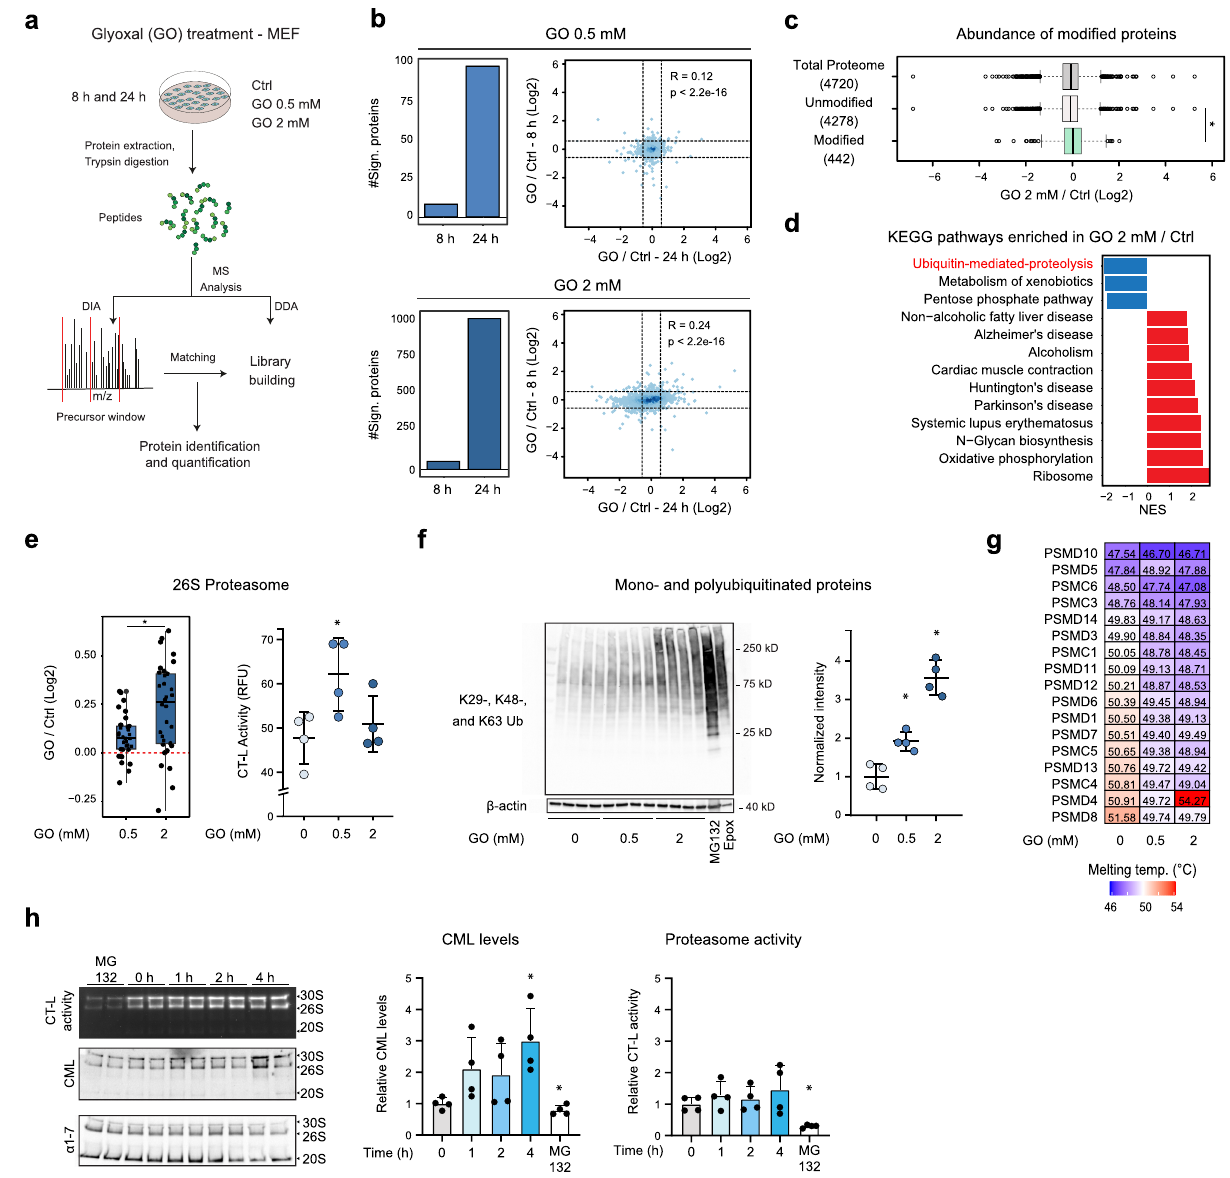
Fig. 3 Alteration of proteostasis induced by glyoxal in MEF. a Work fl ow for the analysis of proteome changes induced in MEF by GO. b Left, number of signi fi cant proteins (absolute log2 fold change>0.58 and q < 0.05) after 8 and 24 h GO treatment. Right, scatterplots comparing the log2 fold changes induced by GO at 8 or 24 h. Dashed lines represent the log2 fold change cut-offs used (±0.58). n = 5 (8 h), n = 4 (24 h). Pearson ’ s product-moment correlation, two-sided. c Distribution of protein fold changes for 2 mM GO (24 h) vs. control (Ctrl). Average values of n = 4 were compared, * p < 0.001, Wilcoxon rank sum test with continuity correction, two-sided. d Gene Set Enrichment Analysis (GSEA) for KEGG pathways based on protein fold changes induced by 2 mM GO (24 h). Normalized enrichment score (NES) indicates pathways enriched among proteins that increase (red) or decrease (blue) upon GO treatment (FDR < 0.05). All quanti fi ed proteins were ranked according to their log2 fold change and used as input for GSEA. e Left, boxplot of fold changes in expression of members of the 26S proteasome after GO treatment (24 h). * p < 0.01, Wilcoxon Rank Sum test with continuity correction, two- sided. Right, proteasome chymotrypsin-like (CT-L) activity in MEF treated with GO (24 h). n = 4, mean + SD, * p < 0.05, one-way ANOVA using Geisser- Greenhouse correction. f Immunoblot for mono- and polyubiquitinated proteins from MEF treated with GO (24 h). Positive control: proteasome inhibitors MG132 (20 µ M, 6 h) or epoxomicin (Epox, 10 nM, 96 h). n = 4, mean ± SD, * p < 0.05, one-way ANOVA using Geisser-Greenhouse correction. g Heatmap representing the melting point temperature of members of 26S proteasome using thermal proteome pro fi ling. h Left, proteasome activity assay using native gel electrophoresis (top) after incubation of puri fi ed proteasome with GO (1 mM, 0, 1, 2, and 4 h, 37 °C). Immunoblot for CML (middle) and proteasome subunits α 1-7 (bottom). Middle, quanti fi cation of CML-modi fi cation. Right, proteasome chymotrypsin-like activity (CT-L) normalized to α 1-7 abundance. Positive control: puri fi ed proteasome incubated with MG132 (100 µ M, 4 h, 37 °C). n = 4, mean + SD, * p < 0.05, one-way ANOVA. Source data are provided as a Source Data fi le. Speci fi c p values are listed in Supplementary Data 6. Related to Supplementary Fig. 3, 4 and Supplementary Data 3.